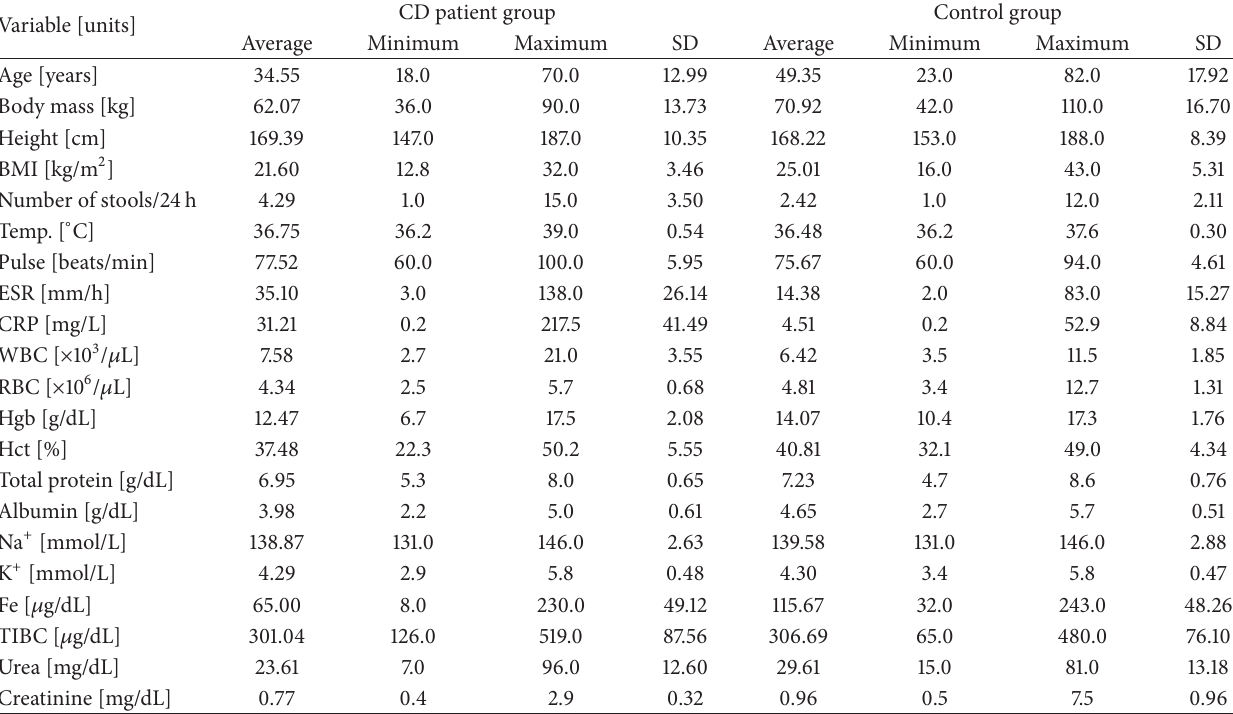
Table 1:Average values forage, body mass,height, BMI,number ofdaily stools,body temperature, andpulseaswell asbiochemical laboratory results for the CD patient group and the control group during hospitalization.